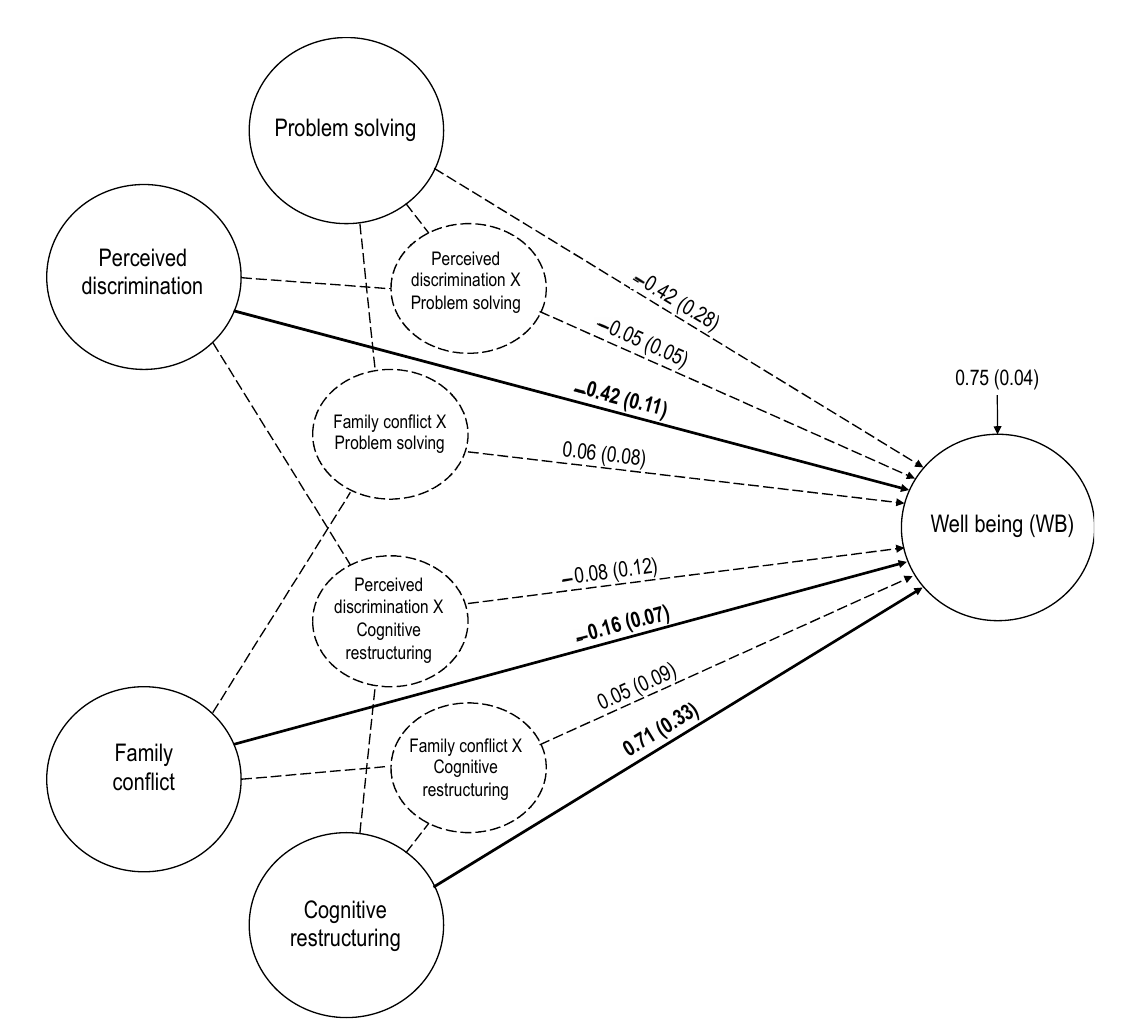
Figure 2. Full structural equation model of well-being regressed on post-migration stressors and coping strategies. The displayed estimates for regression weights are unstandardized (B) with robust standard error in parentheses. Significant weights are indicated by solid-line arrows. Dashed-line arrows indicate nonsignificant regression weights. The weight estimates that are significant are in bold.